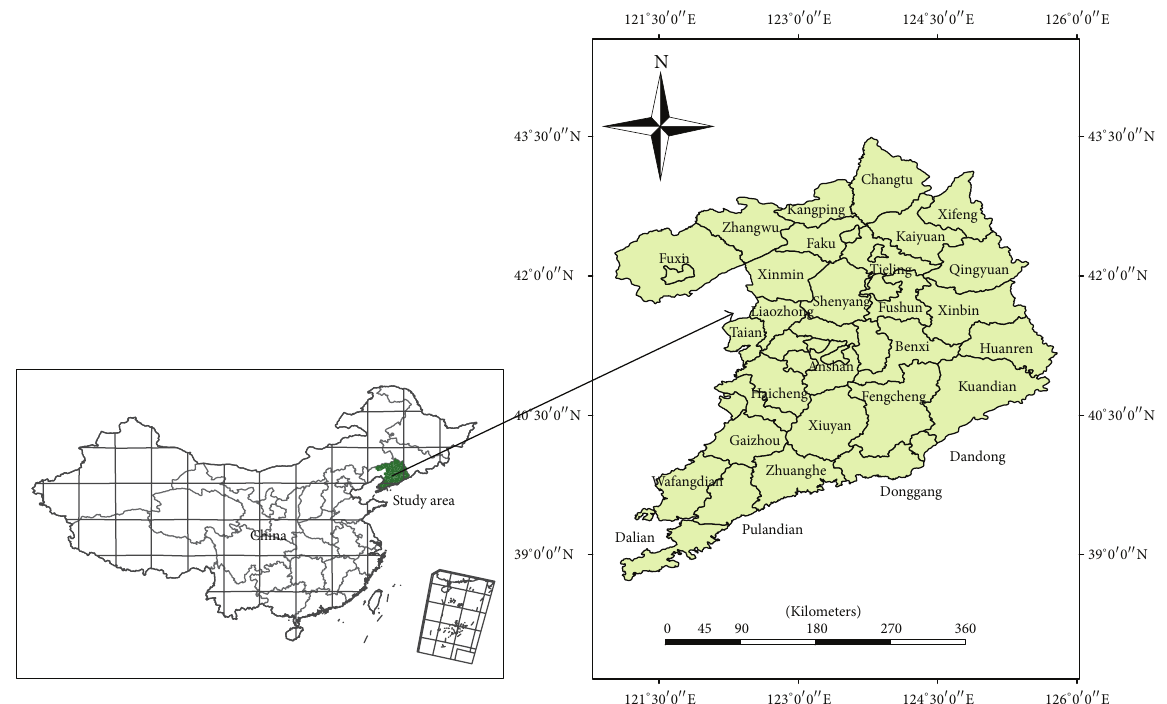
Figure 1: The location of the study area and the main